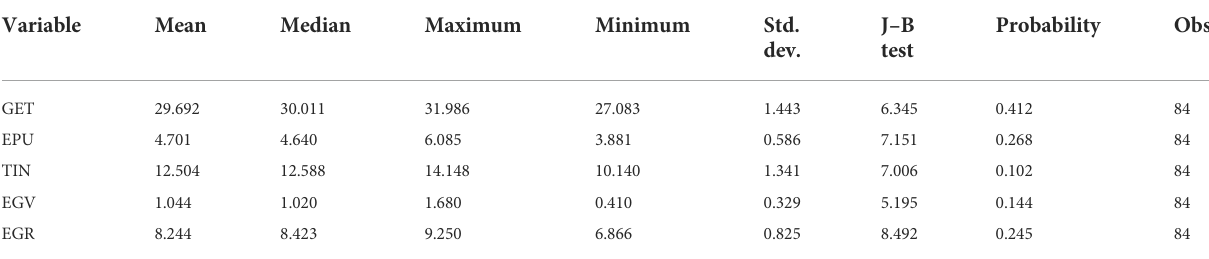
TABLE 2 Descriptive